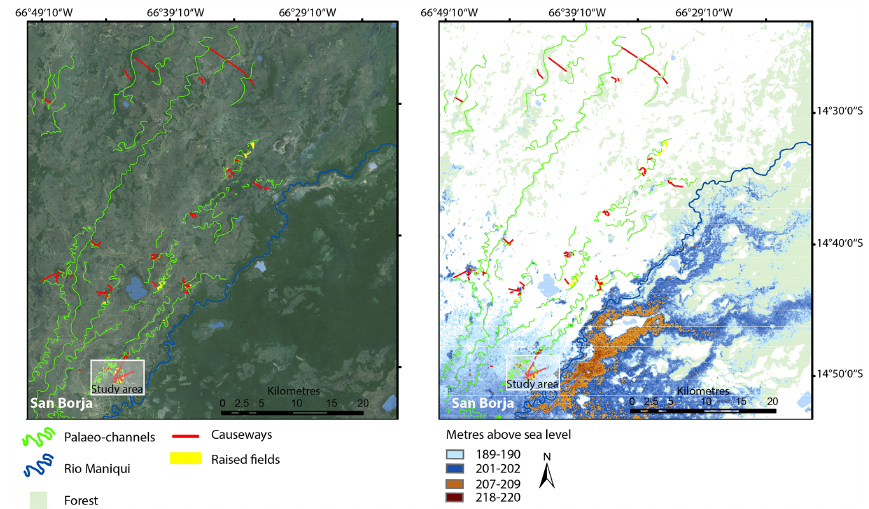
Figure 2. Left panel: Google earth image showing mapped palaeo-river features, causeways (red) and raised field areas (yellow). Right panel: digital elevation model (CGIAR_CSISRTM) including same mapped palaeo-river features, causeways (red) and raised field areas (yellow). Higher areas are relict sediment deposits from former rivers.